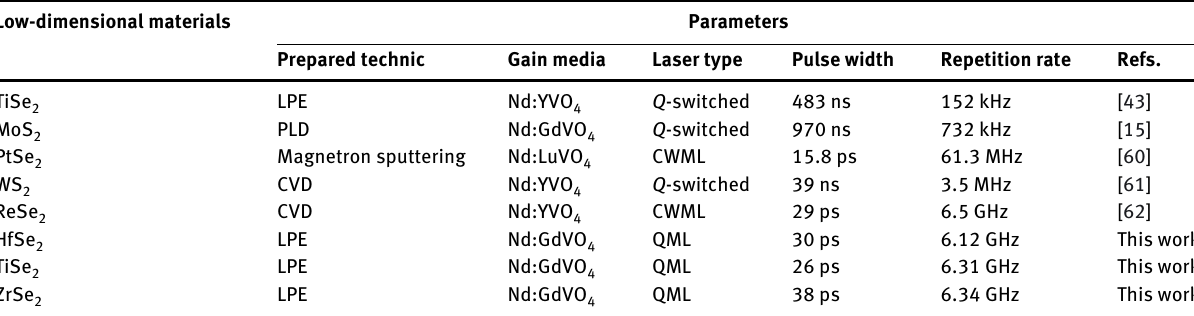
Table 1: Comparisons of pulsed laser performance modulated by TMDCs. Low-dimensional